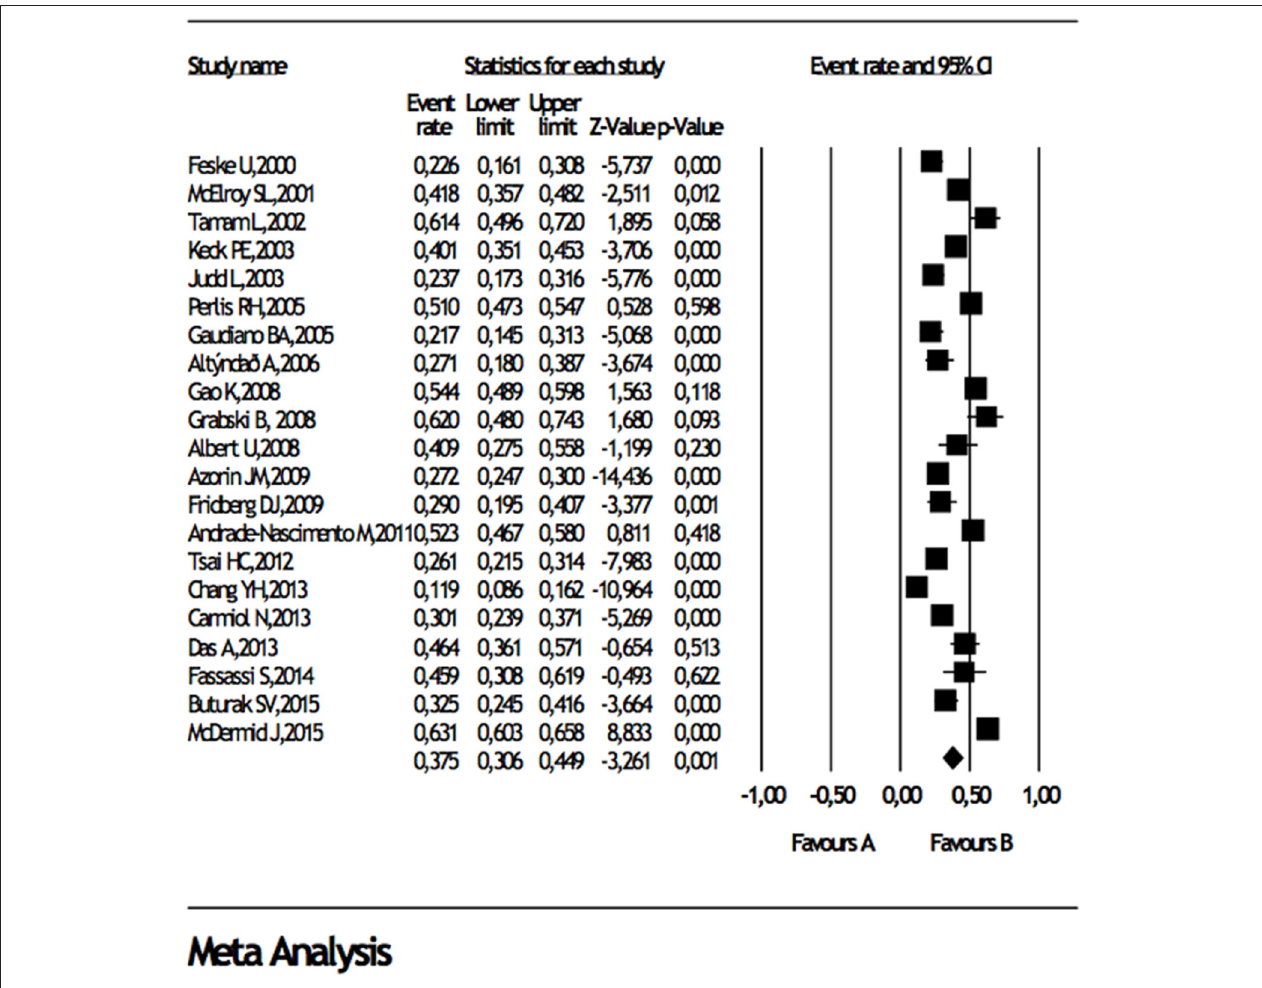
FIGURE 2 | Forest plot for lifetime comorbidity of any anxiety disorder diagnosis in bipolar disorder